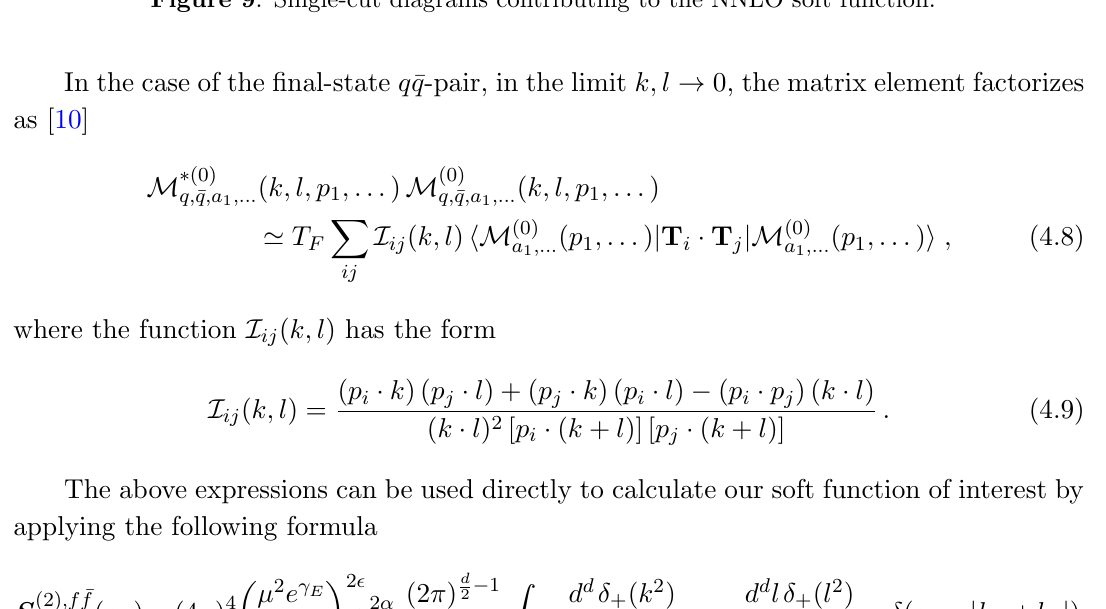
Figure 9 . Single-cut diagrams contributing to the NNLO soft